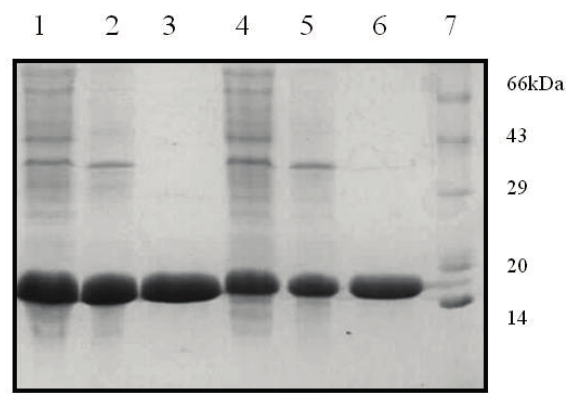
Figure 1. Purification profiles of SSR1 and SSR2 in 15% SDS-PAGE. Lane 1: SSR1 lysate, lane 2: DEAE flow through, Lane 3: Gel filtration elute, lane 4: SSR2 lysate, lane 5: DEAE flow through, lane 6: Gel filtration elute, and lane 7: Standard protein